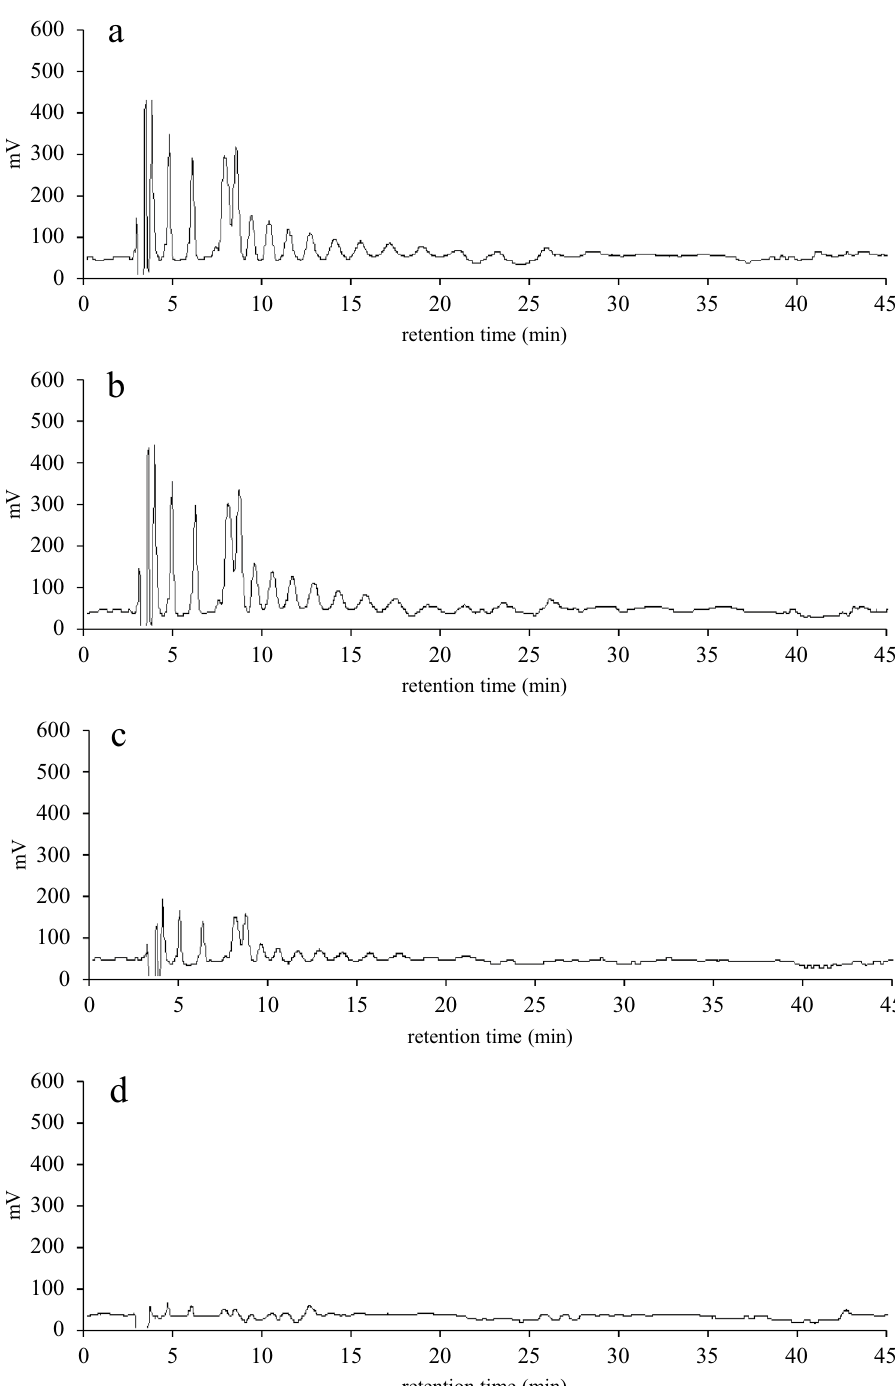
Figure 3. Comparison of extracellular inulin of B. subtilis 168 and UT02 (Ldb1381-1386-introduced 168 strain) cells. The cells were incubated with inulin in PBS at 37 °C for 0.5, 1, and 2 h, and the supernatants were analyzed by HPLC. Inulin elution patterns for 2 h- incubation of B. subtilis 168 cells ( a ), and 0.5 ( b ), 1 ( c ), and 2 ( d ) h-incubation of UT02 cells are